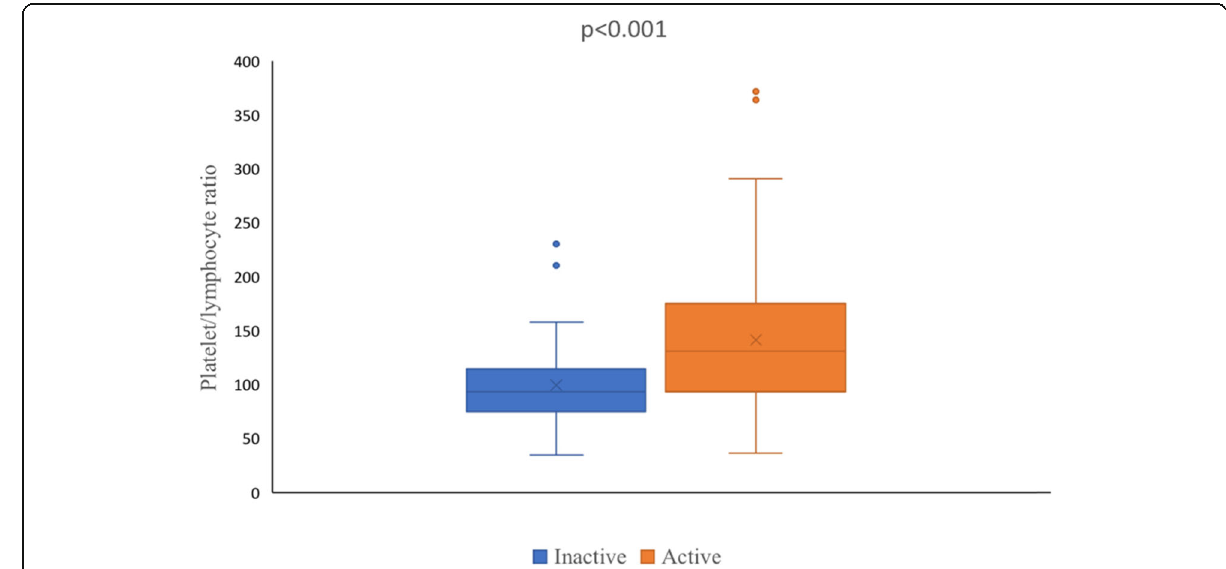
Fig. 2 Mean values of PLR in active and inactive AS